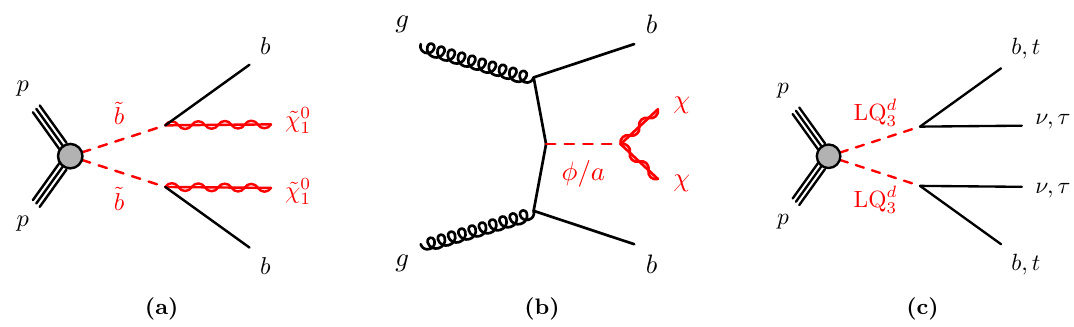
Figure 1 . Diagrams illustrating the processes targeted by this analysis: (a) bottom squark pair production, (b) production of DM particles (indicated with χ ) through the decay of a scalar or pseudoscalar mediator coupling to bottom quarks, and (c) pair production of scalar third-generation down-type leptoquarks decaying to bottom quarks and neutrinos or top quarks and τ -leptons. BSM particles are indicated in red, while SM particles are indicated in